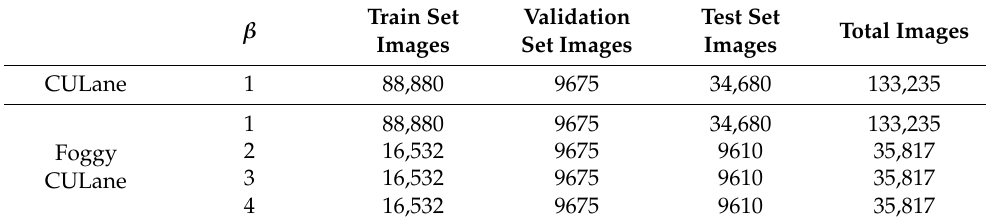
Table 1. The overall file structure of the Foggy CULane dataset compared with the original CULane dataset, β is set to 2, 3, and 4 for simulated fog, and β = 1 represents the original clear image. Train Set Validation Test Set β Images Set Images